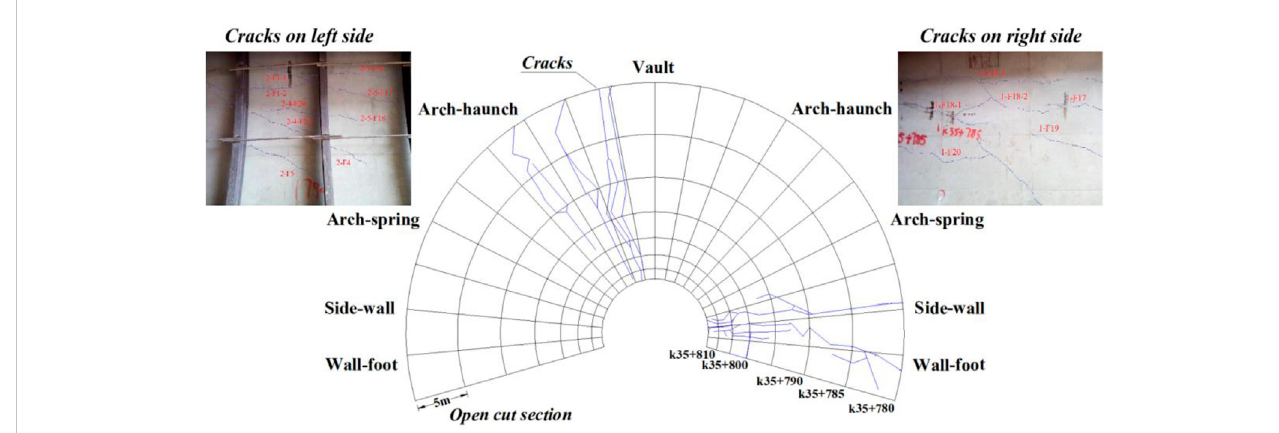
FIGURE 3 Crack distribution of secondary lining at the entrance section of the tunnel.